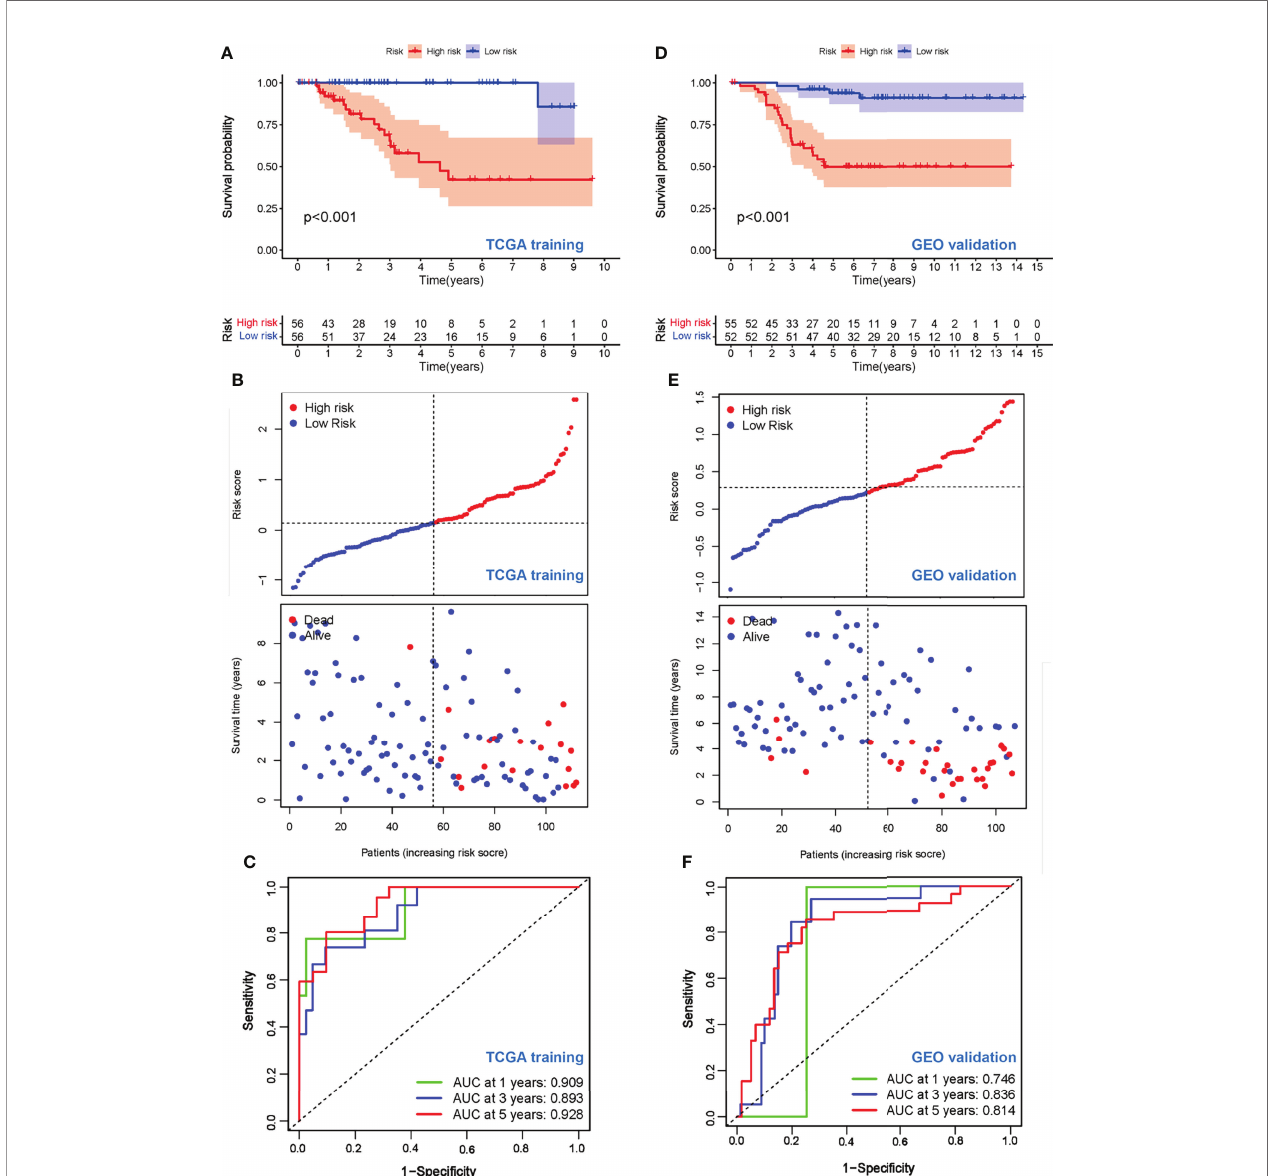
FIGURE 4 | Evaluation of prognostic values of the risk scores. (A) Kaplan – Meier curve of OS for patients in the Treg-related high-risk and low-risk subgroups in the TCGA training cohort. (B) The distributions of risk scores and OS status in the TCGA training cohort. (C) Time-dependent ROC curve of the prognostic values of the TCGA training cohort in 1-, 3-, and 5-year OS. (D) Kaplan – Meier curve of OS for patients in the Treg-related high-risk and low-risk subgroups in the GEO validation cohort. (E) The distributions of risk scores and OS status in the GEO validation cohort. (F) Time-dependent ROC curve of the prognostic values of the GEO validation cohort in 1-, 3-, and 5-year